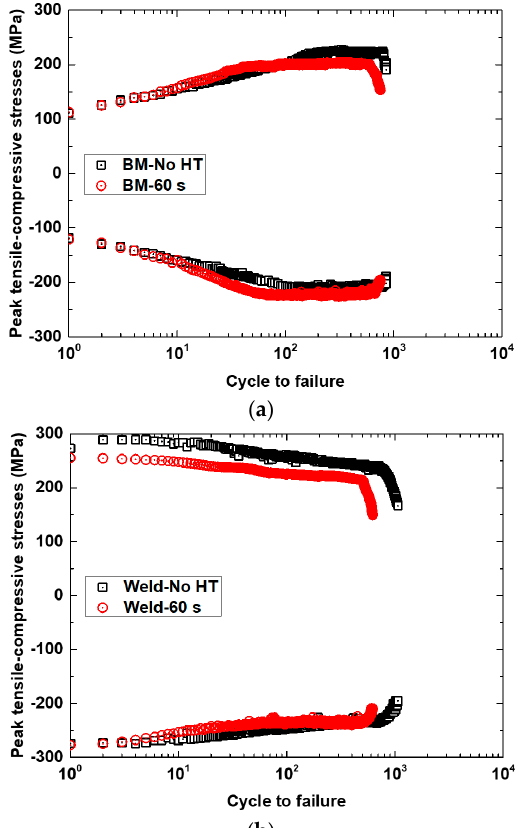
Figure 10. The evolution of peak tensile-compressive stresses for LCF with and without HT of Alloy 800H: ( a ) BM and ( b ) weldments.